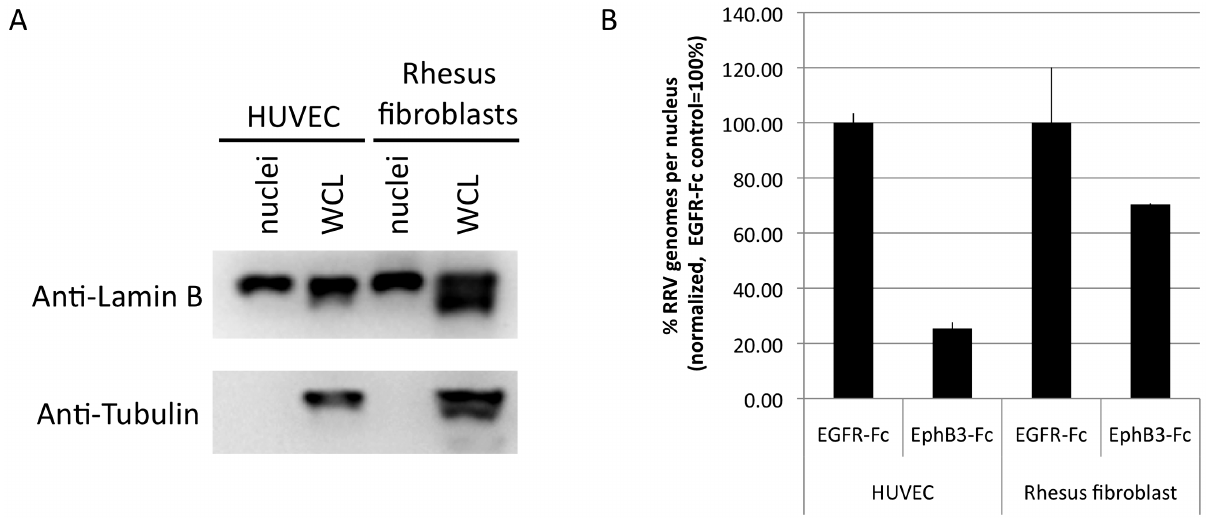
Figure 8. Nuclear delivery of RRV into HUVEC is Eph-dependent. ( A ) Western Blot analysis of nuclear fractions (nuclei) and whole cellular lysates (WCL) prepared from HUVEC and rhesus fibroblasts. Whole cellular lysate and nucleic fraction were probed for lamin B (nuclear marker) and tubulin (cytoskeleton). ( B ) Quantification of RRV genomes in the nuclear fraction 4 h post infection. HUVEC or rhesus fibroblasts were infected with RRV for 4 h. Virus was pre-incubated with EphB3-Fc or EGFR-Fc (control) for 45 minutes. The cells were washed, harvested by trypsinization, and nuclei were prepared. Total DNA was extracted from the nuclei and copy number of the viral genome and the cellular GAPDH locus was quantified by realtime PCR. The ratio of RRV/GAPDH copy number for the control infection (EGFR-Fc) in each cell type was set to 100%. The average of three independent experiments is shown, error bars represent the standard deviation. The difference in HUVEC is significant (p=0.00003), the difference in rhesus fibroblasts is not (p=0.125) (n=3, two sided student’s t-test with unequal